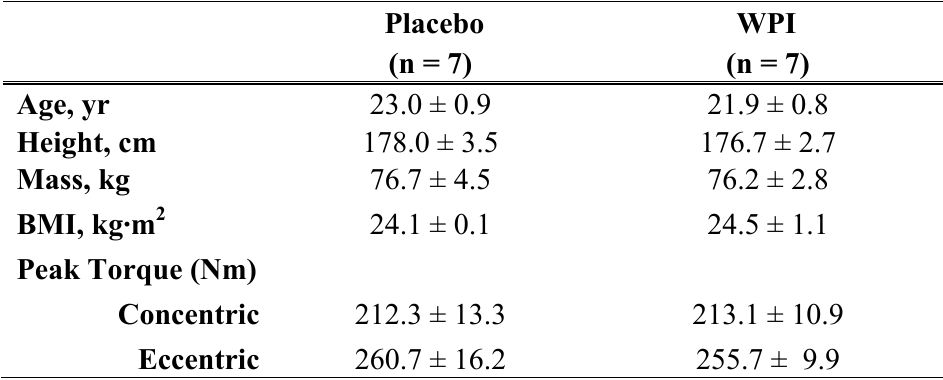
Table 1. Subject characteristics and Peak Torque.